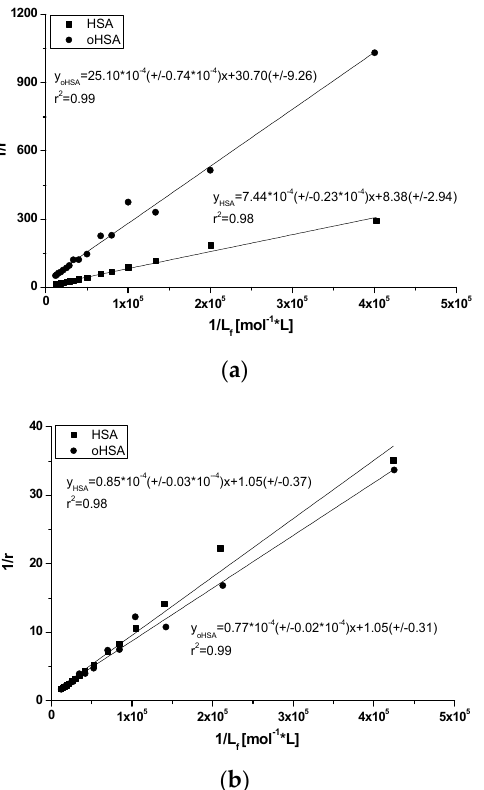
Figure 11. The Klotz plots for DAPT-HSA and DAPT-oHSA systems at ( a ) λ ex 275 nm and ( b ) λ ex 295 nm. Table 5. Binding parameters for DAPT-HSA and DAPT-oHSA systems at λ ex 275 nm and λ ex 295 nm.